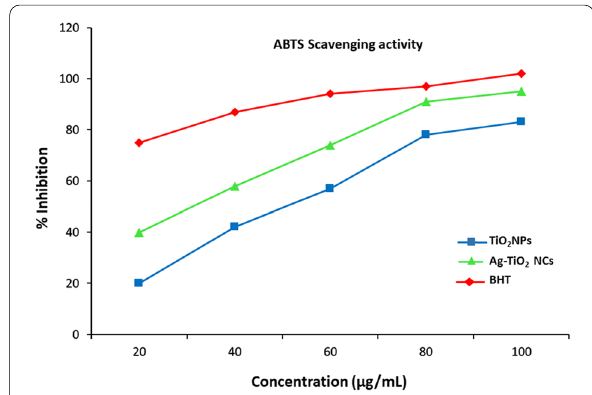
Fig. 9 ABTS assay showing enhanced antioxidant activity of green-synthesised Ag–TiO 2 NCs at different concentrations